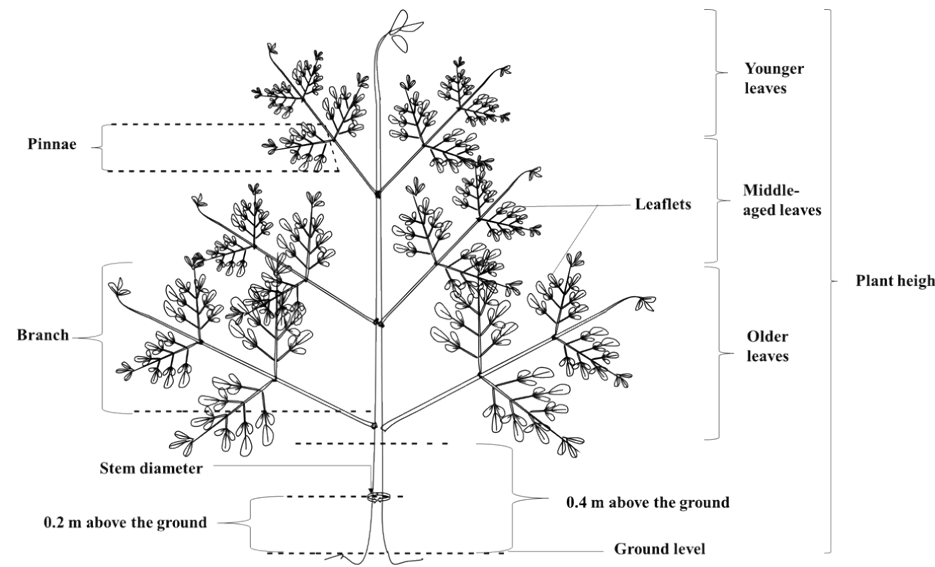
Fig. 1: Moringa oleifera morphological sections used for the experiments (source: T eTTeh et al., 2019 with modifications) Tab. 2: Temperature (maximum and minimum), rainfall, and relative humidity recorded daily from the three agro-ecological zones in Ghana. Agro-ecological